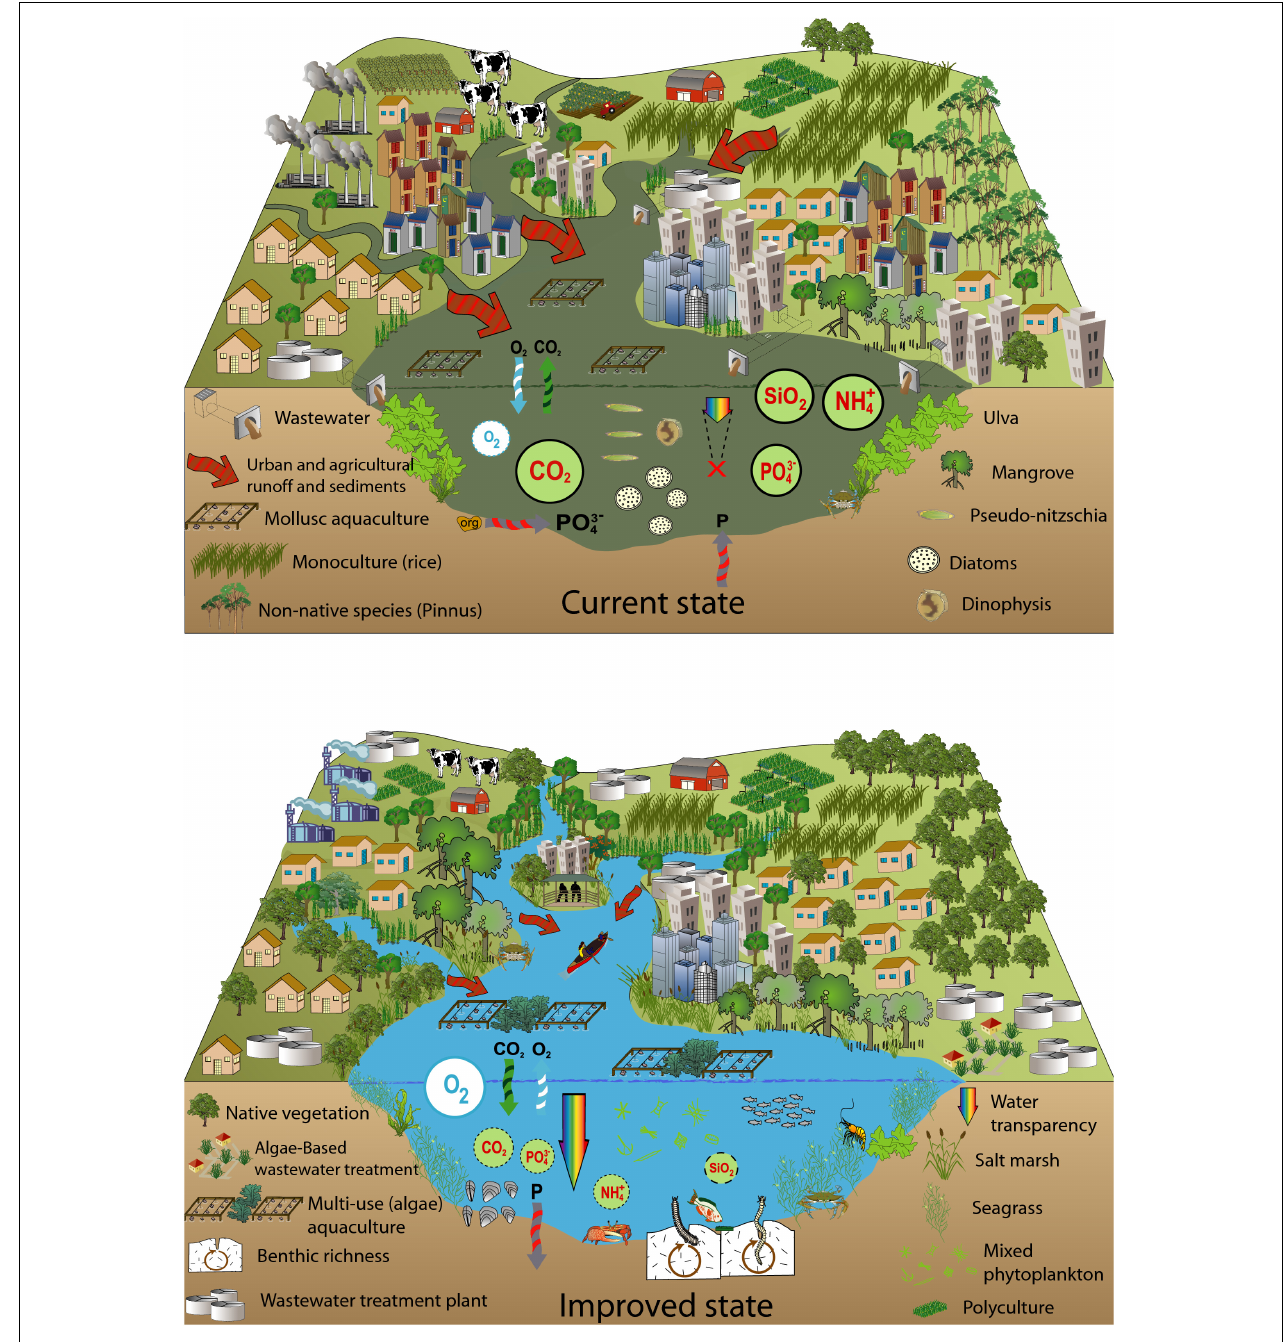
FIGURE 5 | Current state of the Bay of Santa Catarina Island, polluted by organic and inorganic enrichment, and a future scenario after improved long-term wastewater treatment and wetlands restoration.